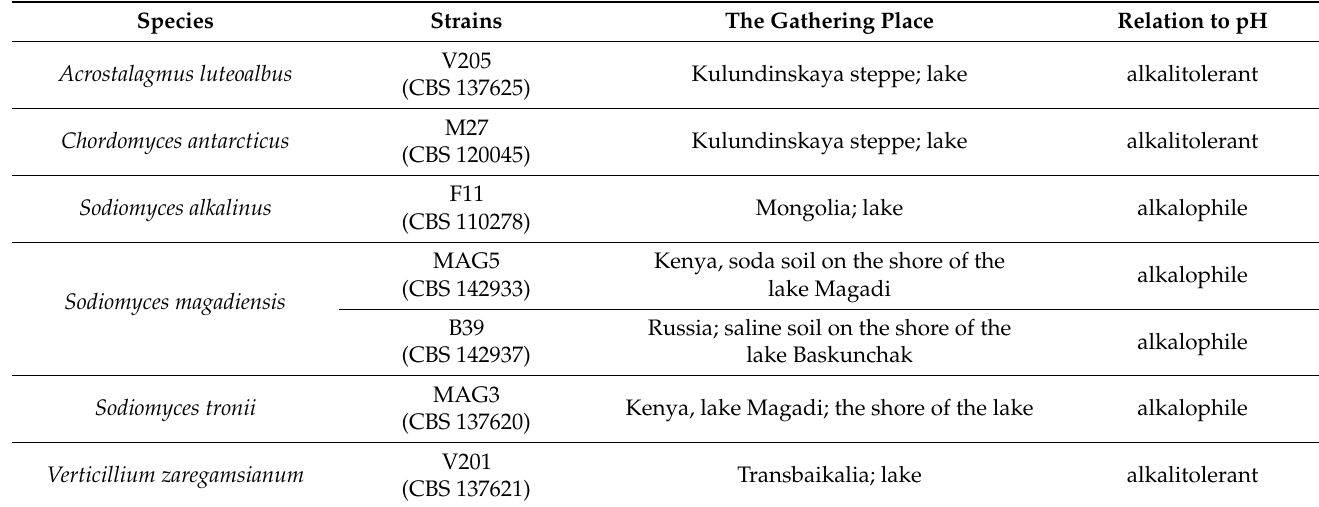
Table 2. Cultures used for analysis of